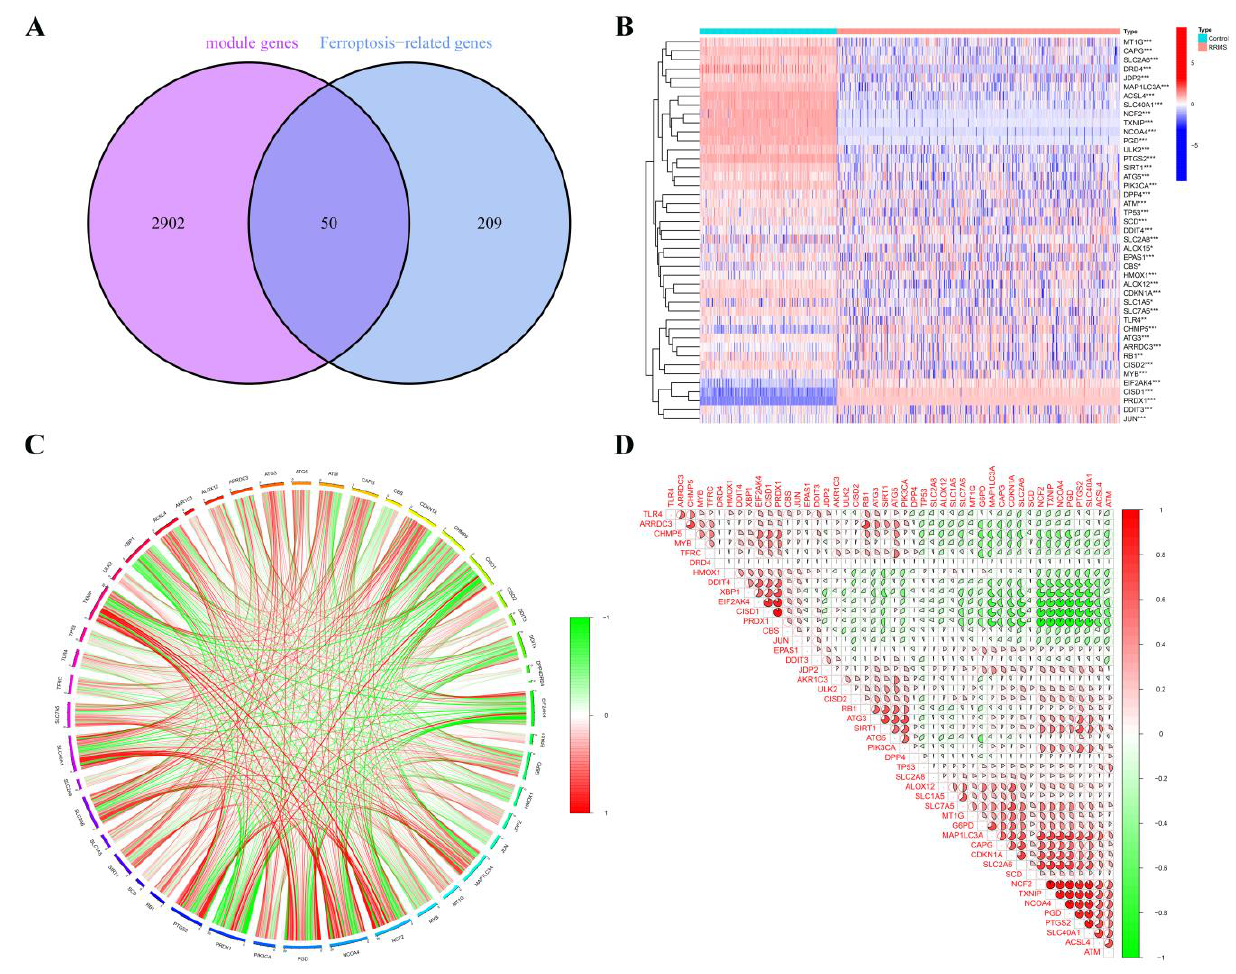
Figure 4. Identification and analysis of overlapping RRMS-related module genes. ( A ) The Venn diagram shows the numbers of overlapping genes. ( B ) The expression patterns of overlapping RRMS-related module genes are shown in the heatmap. * p < 0.05, ** p < 0.01, *** p < 0.001. ( C ) The gene relationship network diagram of 50 overlapping RRMS-related module genes is shown, with red and green colors indicating positive and negative correlations, respectively. ( D ) The correlation analysis of overlapping RRMS-related module genes. The area of the pie chart represents the correlation